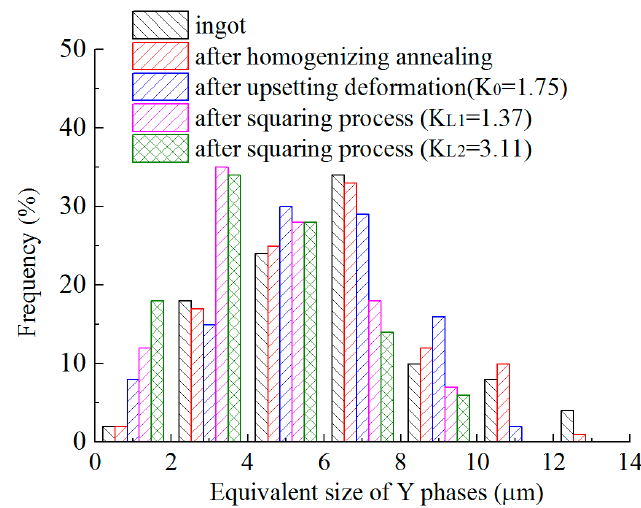
Figure 6. Distribution of the sizes of Y phases after the heat treatment and forging processes.